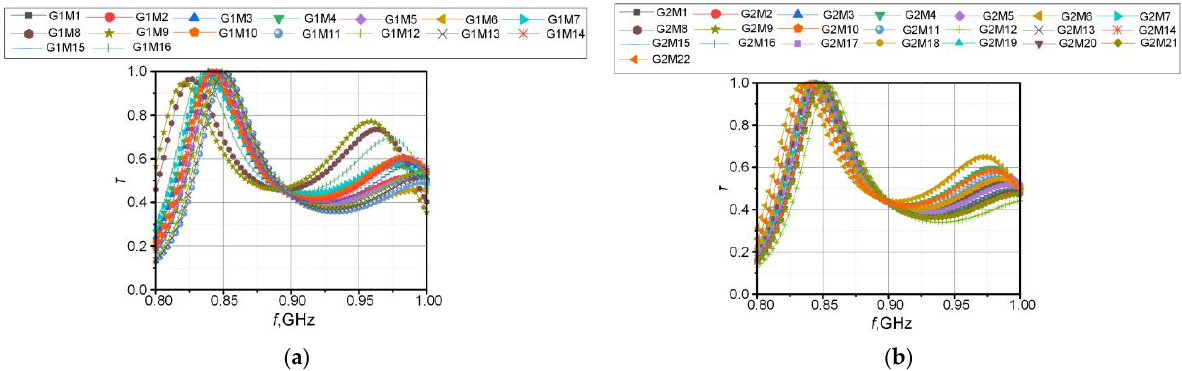
Figure 17. Power transfer coefficient complex impedance of RFIDtex transponder antenna depending on textile substrate: ( a ) Group G1; ( b ) Group G2.